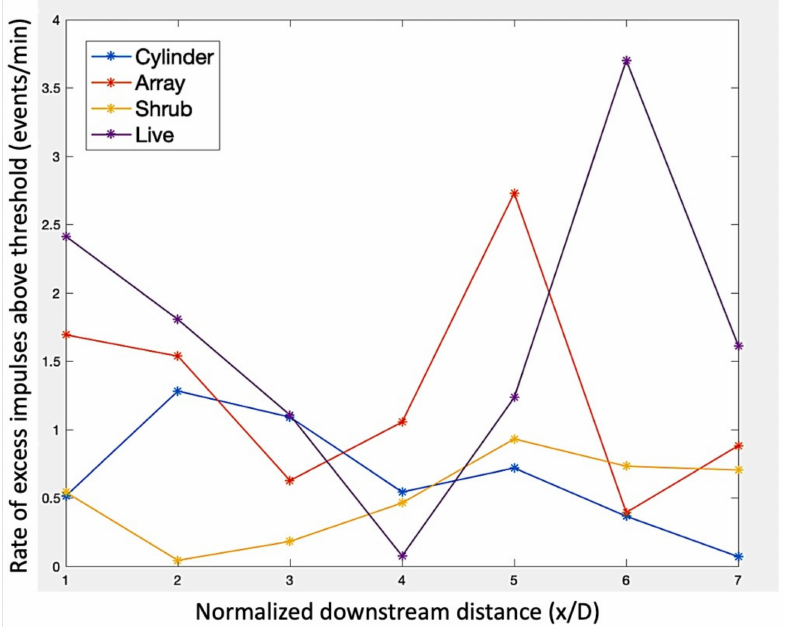
Figure 13. The variation of frequency is calculated by the number of impulses ( I i > I cri ) above a critical level over a four-minute period at different normalized distance (x/D) for the four vegetations